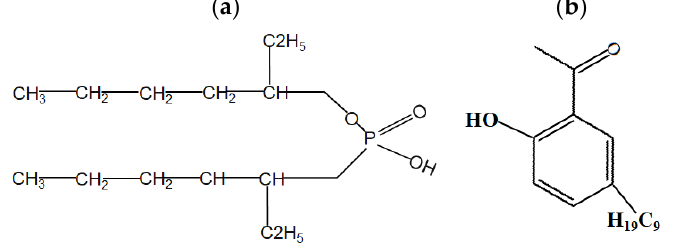
Figure 3. Structure of ( a ) PC88A and ( b ) LIX 84.